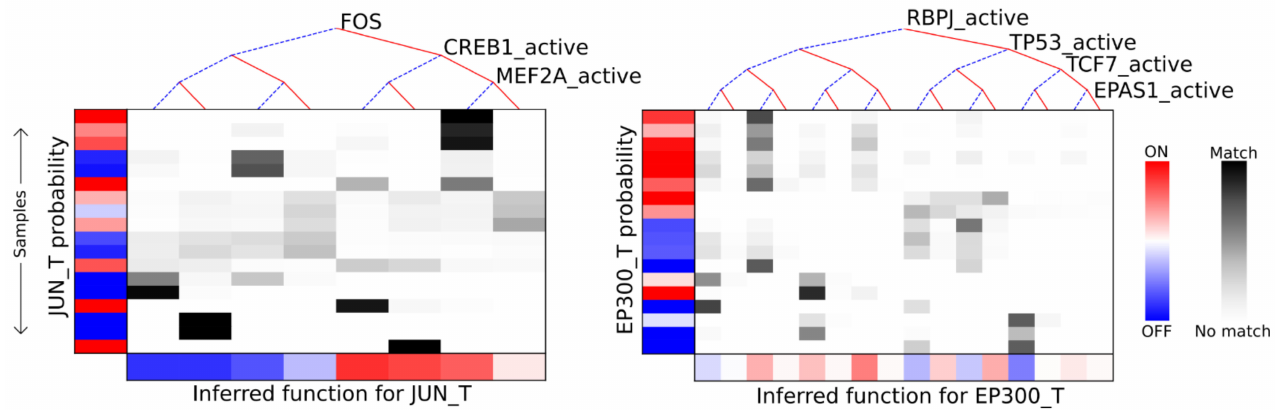
Figure 3. Examples demonstrating BooleaBayes regulatory function inference. Left: the inferred function for JUN tran- scription. JUN_T has three regulators: FOS, CREB1_active, and MEF2A_active. A Boolean function of 3 regulators has 2 3 = 8 possible input configurations (e.g., FOS = 0, CREB1_active = 0, MEF2A_active = 0). Each column of the figure corre- sponds to one of the possible regulator configurations, from all regulators being OFF (left-most column) to all regulators being ON (rightmost column). Each row corresponds to one of the 18 AML samples. The red and blue colors along the far left show whether JUN_T (the target node) is ON or OFF in each sample. The white-black color scale shows how closely each sample (row) corresponds to a given input configuration (column). For example, the top three samples (rows) are most likely to correspond to FOS = 1, CREB1_active = 1, MEF2A_active = 0, as is shown by the black and dark grey cells in the first three rows of that column. In both samples, JUN_T is likely to be OFF (indicated by the blue color). Thus, the inferred regulatory function for JUN_T (bottom row) says that if FOS = CREB1_active = MEF2A_active = 0, JUN_T is very likely to turn OFF. Right: inferred function for EP300 transcription. Unlike JUN_T, there are many conditions for which there was no observed data, such as RBPJ_active = 0, TP53_active = 0, TCF7_active = 0, and EPAS1_active = 1 (second condition from the left). In these cases, the inferred rule has a near 50% chance for EP300_T to turn ON or OFF, as there are no data indicating what should happen in these